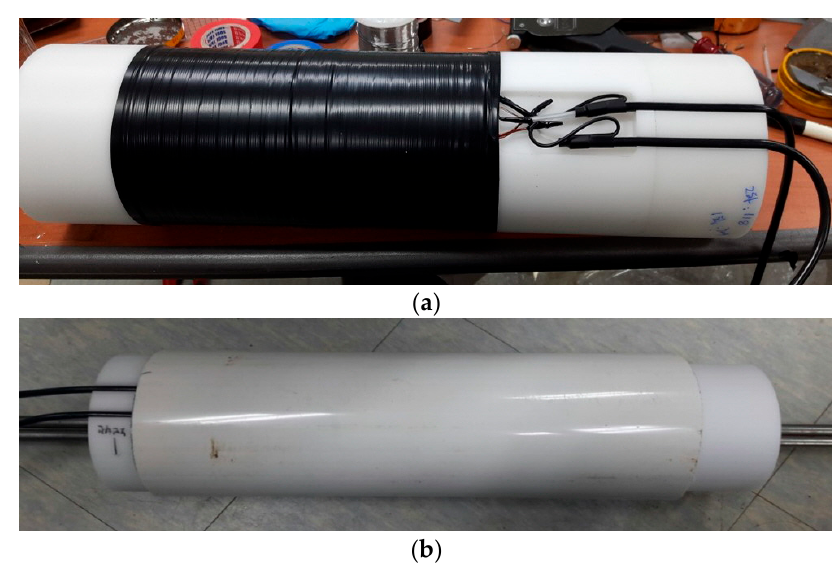
Figure 2 . Embedded EM sensor . ( a ) Connection with coils and cable, ( b ) External protection cover.